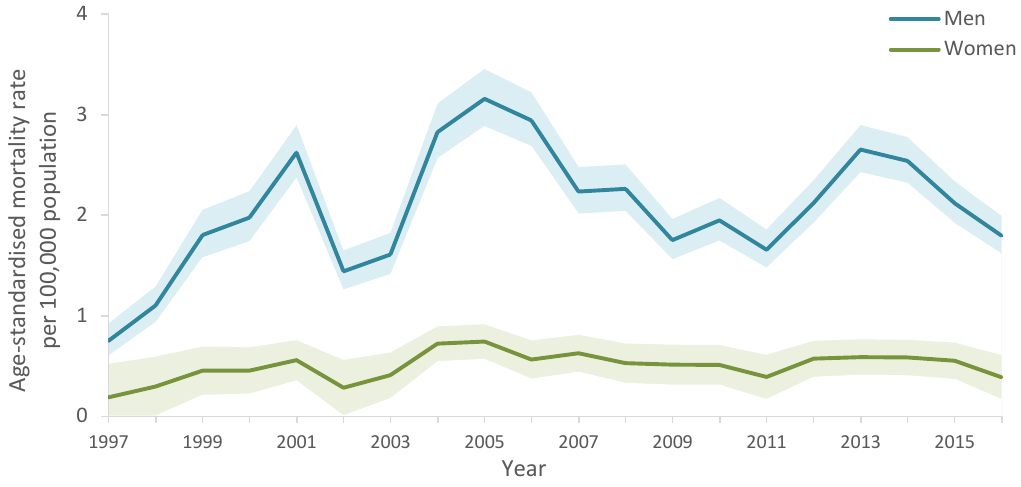
Figure 1. Age-standardised suicide mortality rate (95% CI bands) by sex in South Africa, 1997–2016. The joinpoint regression analyses identified one change point or joinpoint for men (2001) and women (2004), resulting in two linear segments or changes in the mortality rate (Figure 2). The mortality rate remained stable for men within each period identified by the model, as the increase in mortality rates from 1997 to 2001 (APC = 29.5%, 95% CI 0–67.8) and decrease in mortality rates from 2001 to 2016 (APC = −1.2%, 95% CI 4.2–2.0) were not significant. The mortality rate for women increased significantly by 12.6% (95% CI 1.5–25.0) from 1997 to 2004 and then stabilised.